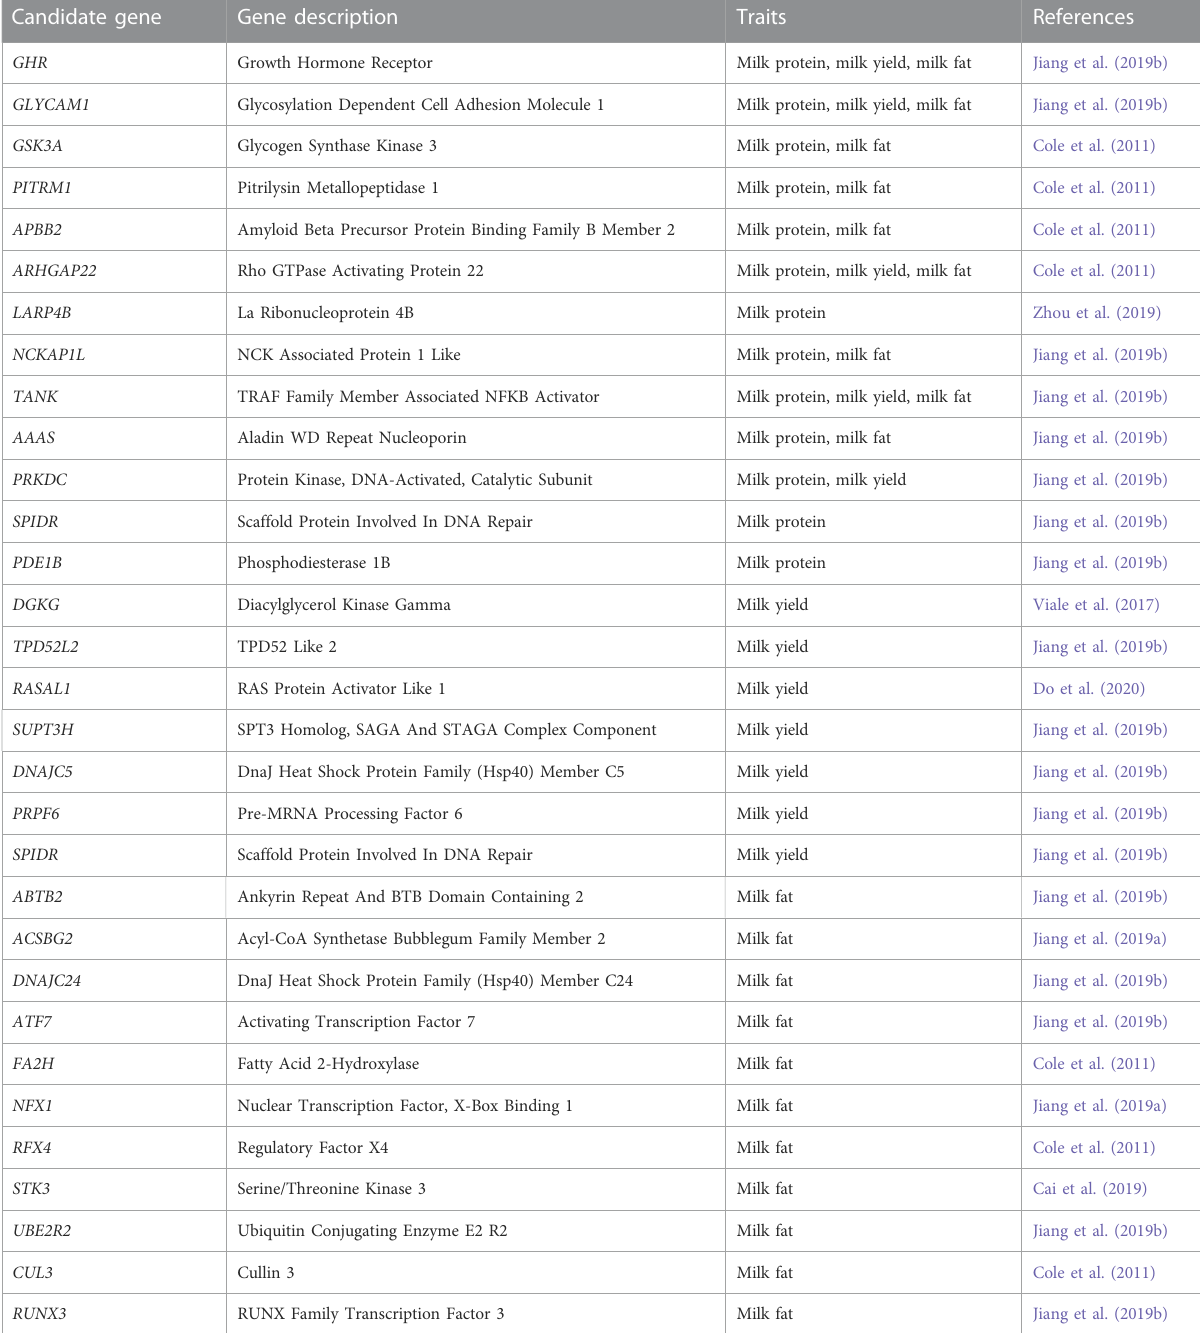
TABLE 3 Candidate genes located on the QTLs of bovine milk production